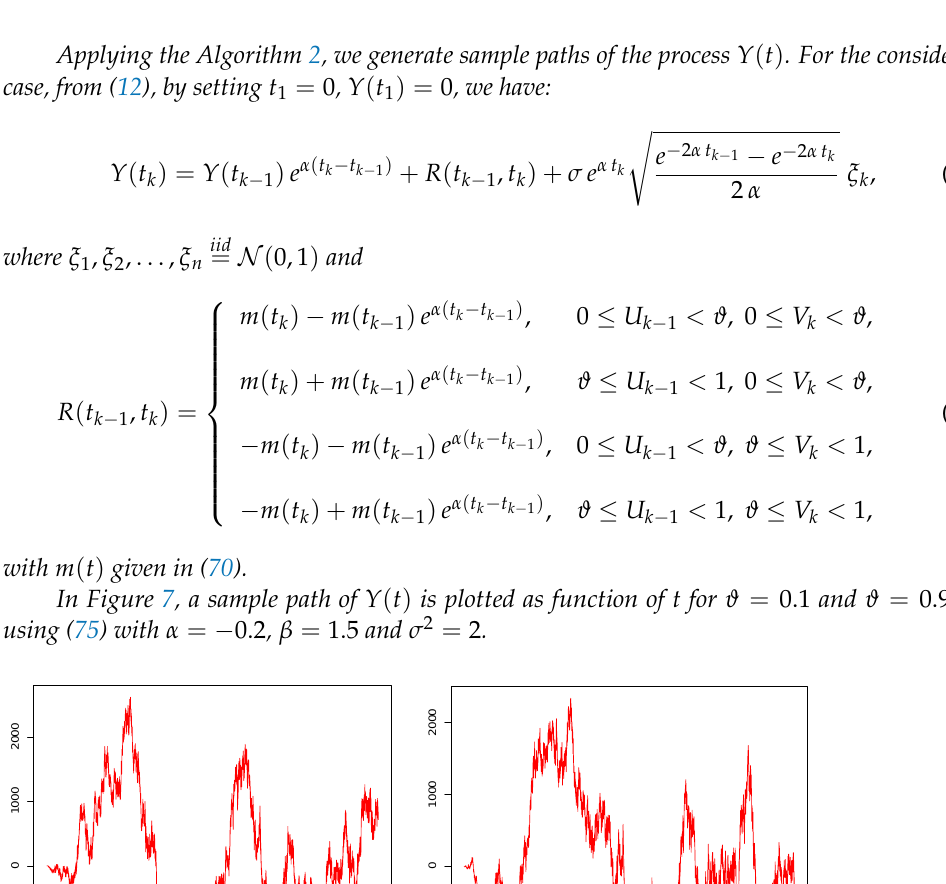
, s 2 and c t , obtained by t t